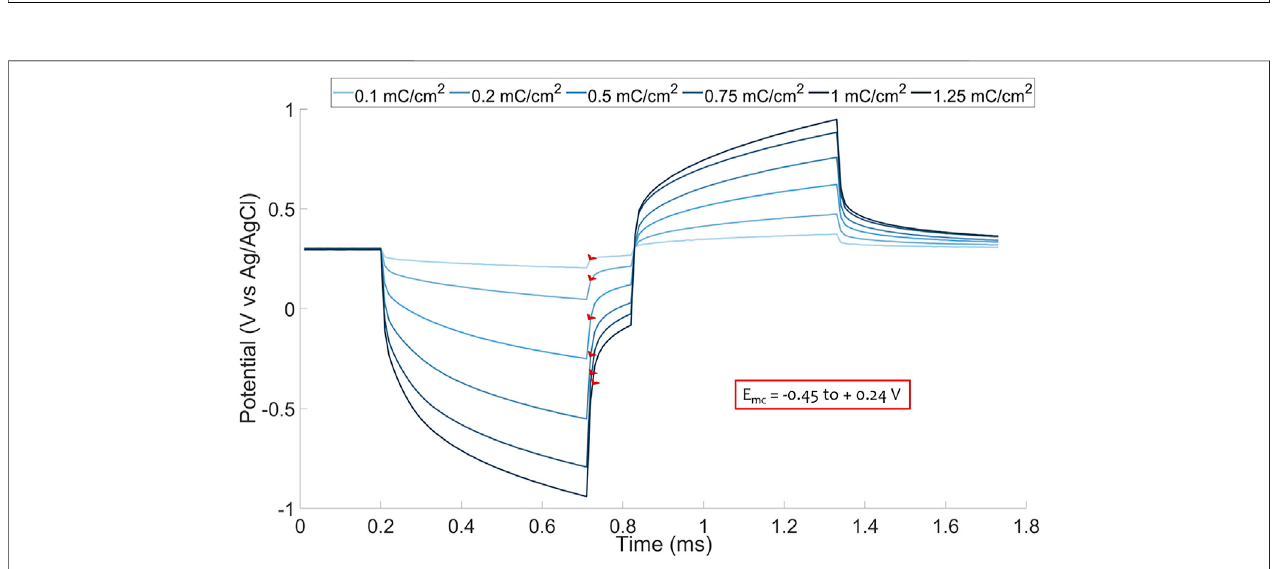
FIGURE 3 | E mc Characterization. Voltage transients of one PtIr-CF vs the Ag/AgCl reference electrode for charge density from 0.1 to 1.25 mC/cm 2 . The E mc ranges from − 0.45 to 0.24 V in the range of the water electrolysis window for PtIr coatings ( − 0.6 to 0.8 V) (Rose and Robblee, 1990).